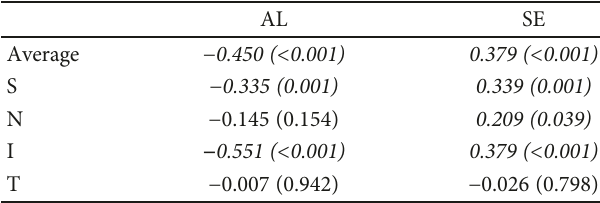
Table 2: Correlation between overall and regional peripapillary RNFL thickness and myopic